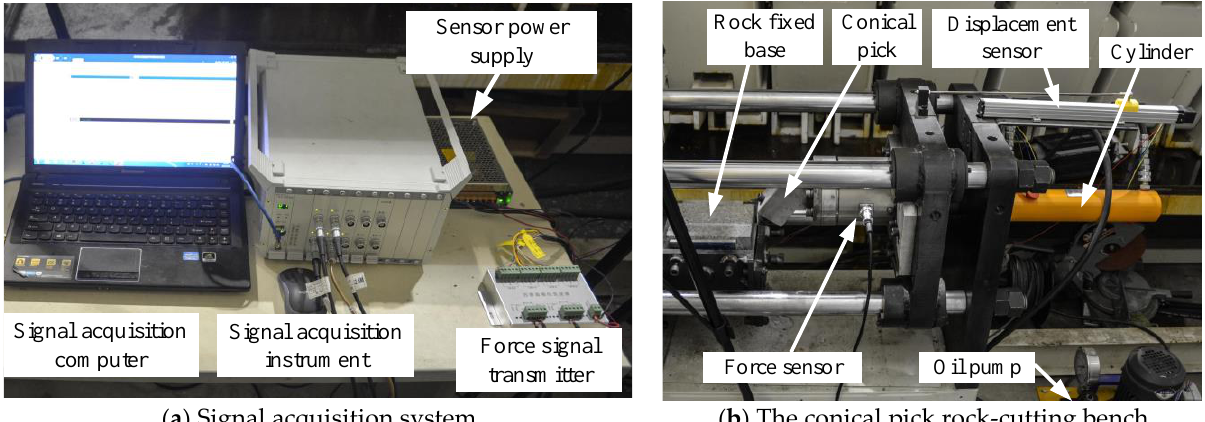
Figure 5. The experimental test bench of conical pick rock-cutting.